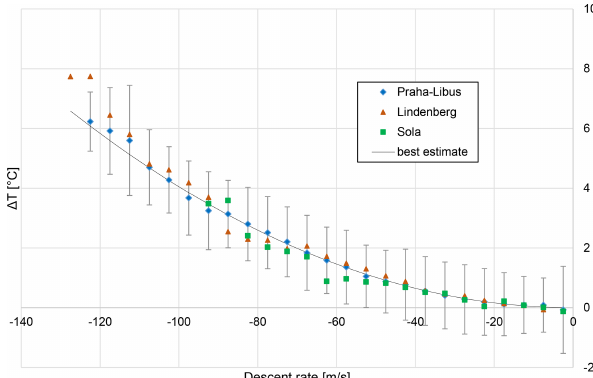
Figure 17. The dependence of temperature differences between as- cent and descent on descent rate, showing Praha-Libus, Lindenberg and Sola averaged over different times. For Praha-Libus, the stan- dard deviation and best estimate are shown.